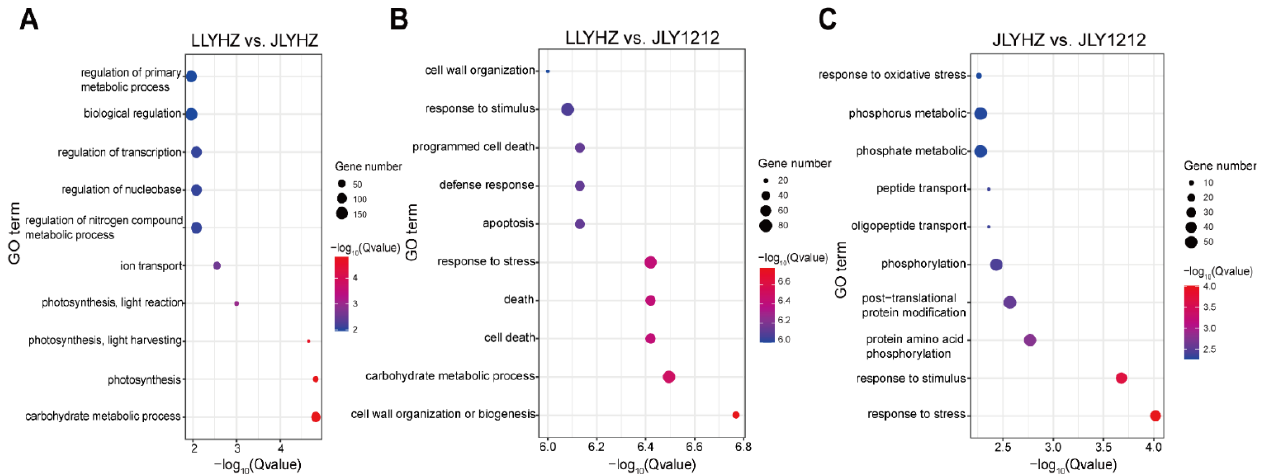
Figure 4. Gene ontology (GO) analysis of the biological process of up-regulated genes in spikelets at flowering stage between LLYHZ and JLYHZ ( A ), between LLYHZ and JLY1212 ( B ), and between JLYHZ and JLY1212 ( C ).